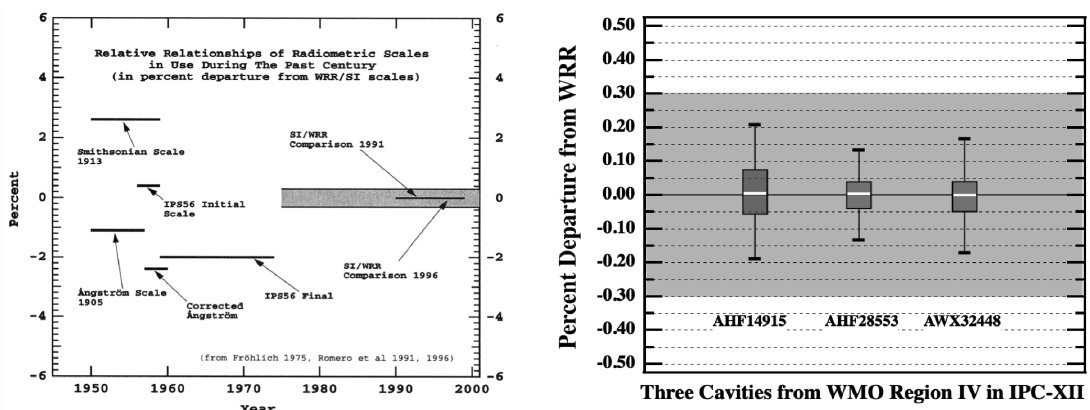
Figure 1. Left panel [8] shows efforts to establish a radiometric scale during the 20th century. The shaded band marks the adoption of the WRR. Relative relationships of the scales with respect to the current WRR are shown. Right panel illustrates the results for three cavities from WMO Region IV (North American Region) which participated in IPC-XII in 2015. Box plot data: box midlines are medians, box lower and upper boundaries are at the 25th and 75th percentiles and the box whisker caps are at the 2nd and 98th percentiles. Shaded bands in both panels denote the accepted uncertainty in the WRR. The scale in righthand panel is expanded by a factor of 12 with respect to panel on